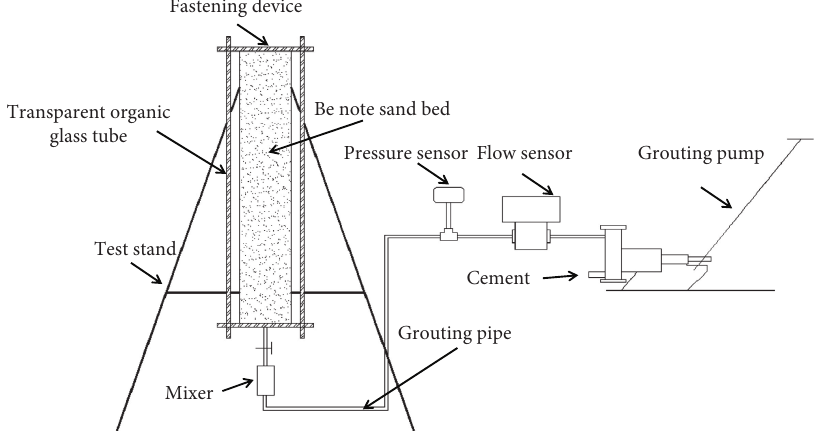
Figure 1: Penetration grouting test device.